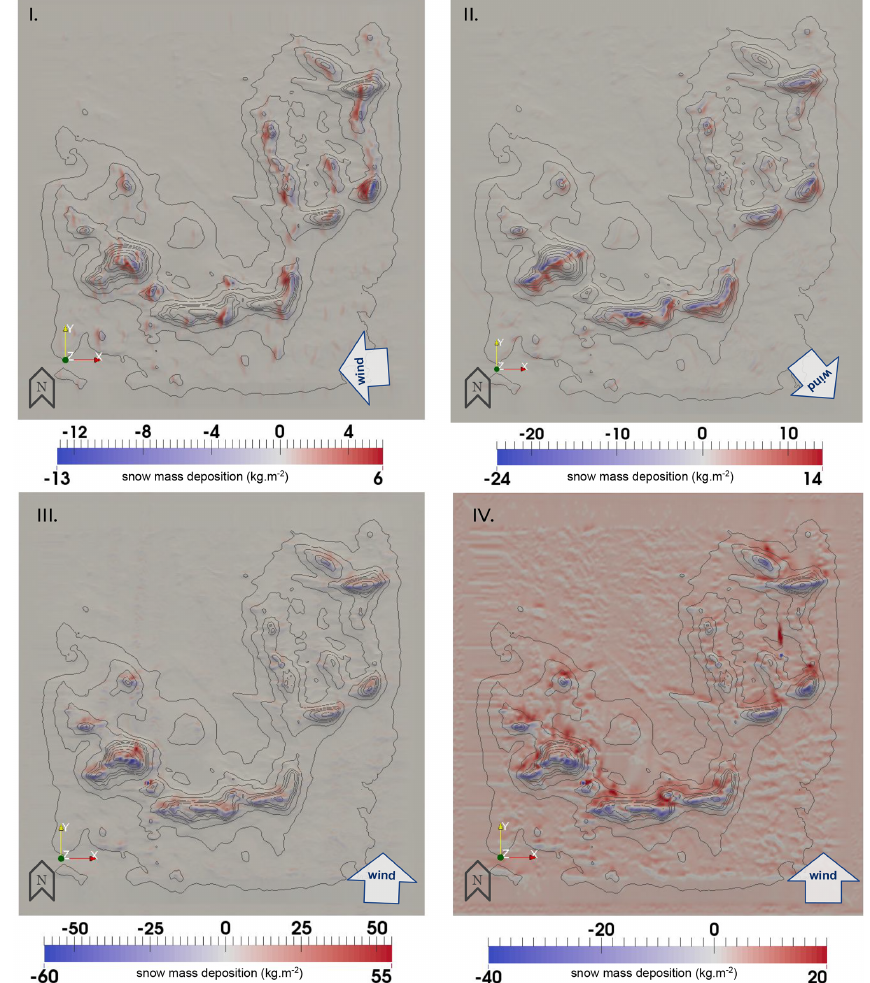
Figure 4. Extrapolated snow deposition results (kgm − 2 ) for the four atmospheric events (I–IV) identified in the period between the two successive laser scans. The arrows in the bottom-right corner indicate the direction of the fluid